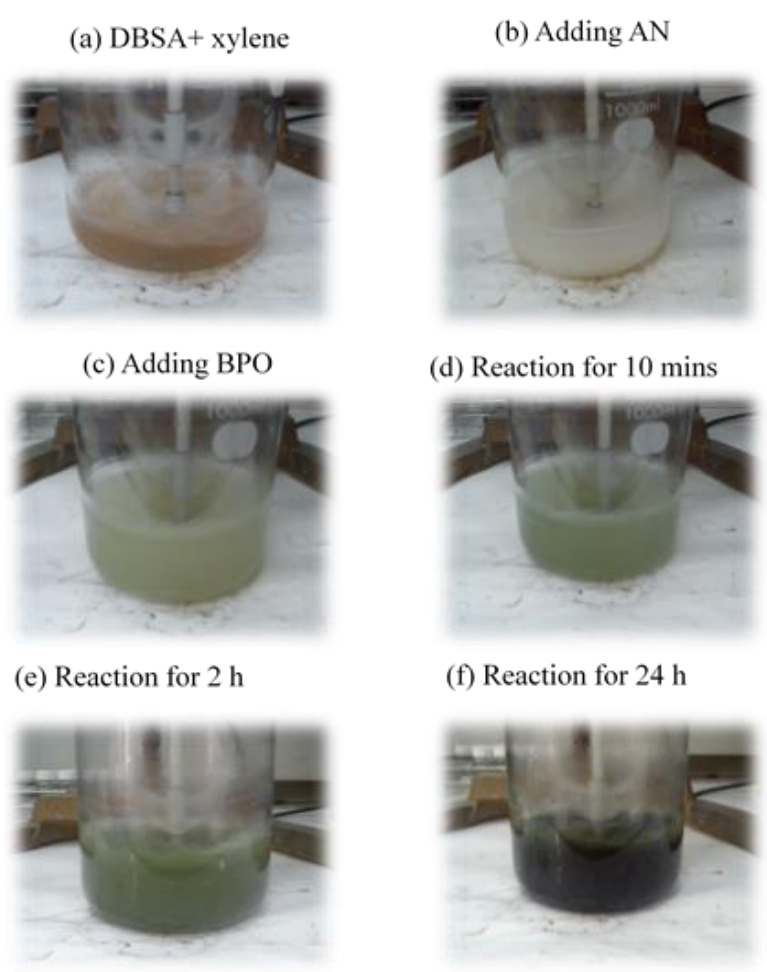
Figure 1. The synthesis process of PANDB with the molar ratio of AN:BPO:DBSA = 1.0:0.8:0.8 in xylene for 24 h at 25 °C.